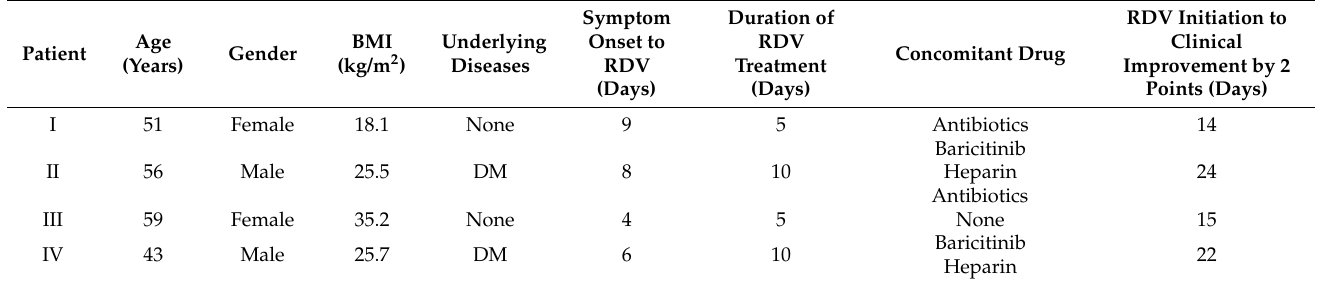
Figure 2. Clinical improvements as assessed by a 6-point scale within 10 or 14 days after remdesivir administration in the non-oxygen therapy group ( A ) and the oxygen therapy group ( B ). Table 2. Clinical characteristics of patients who did not achieve a 2-point clinical improvement on the 14th day of RDV administration in oxygen therapy